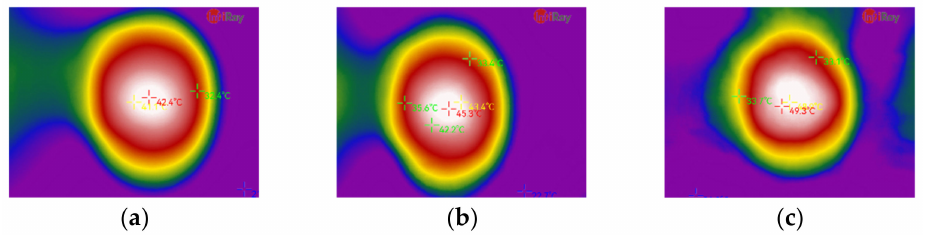
Figure 6. Thermal contour map of milling hole: ( a ) F1-S2; ( b ) F3-S5; ( c )